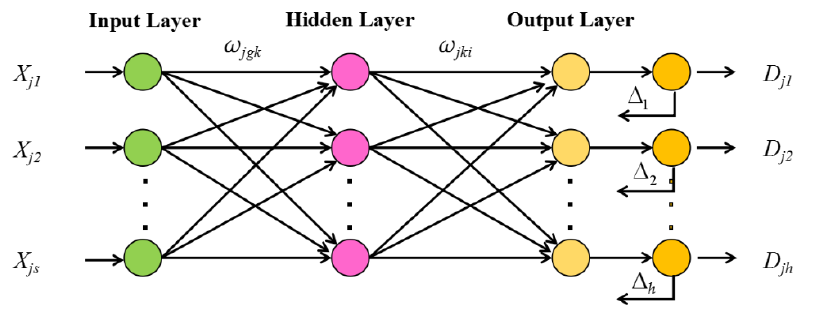
Figure 2. Diagram of Back Propagation Neural Networks ( BPNN).